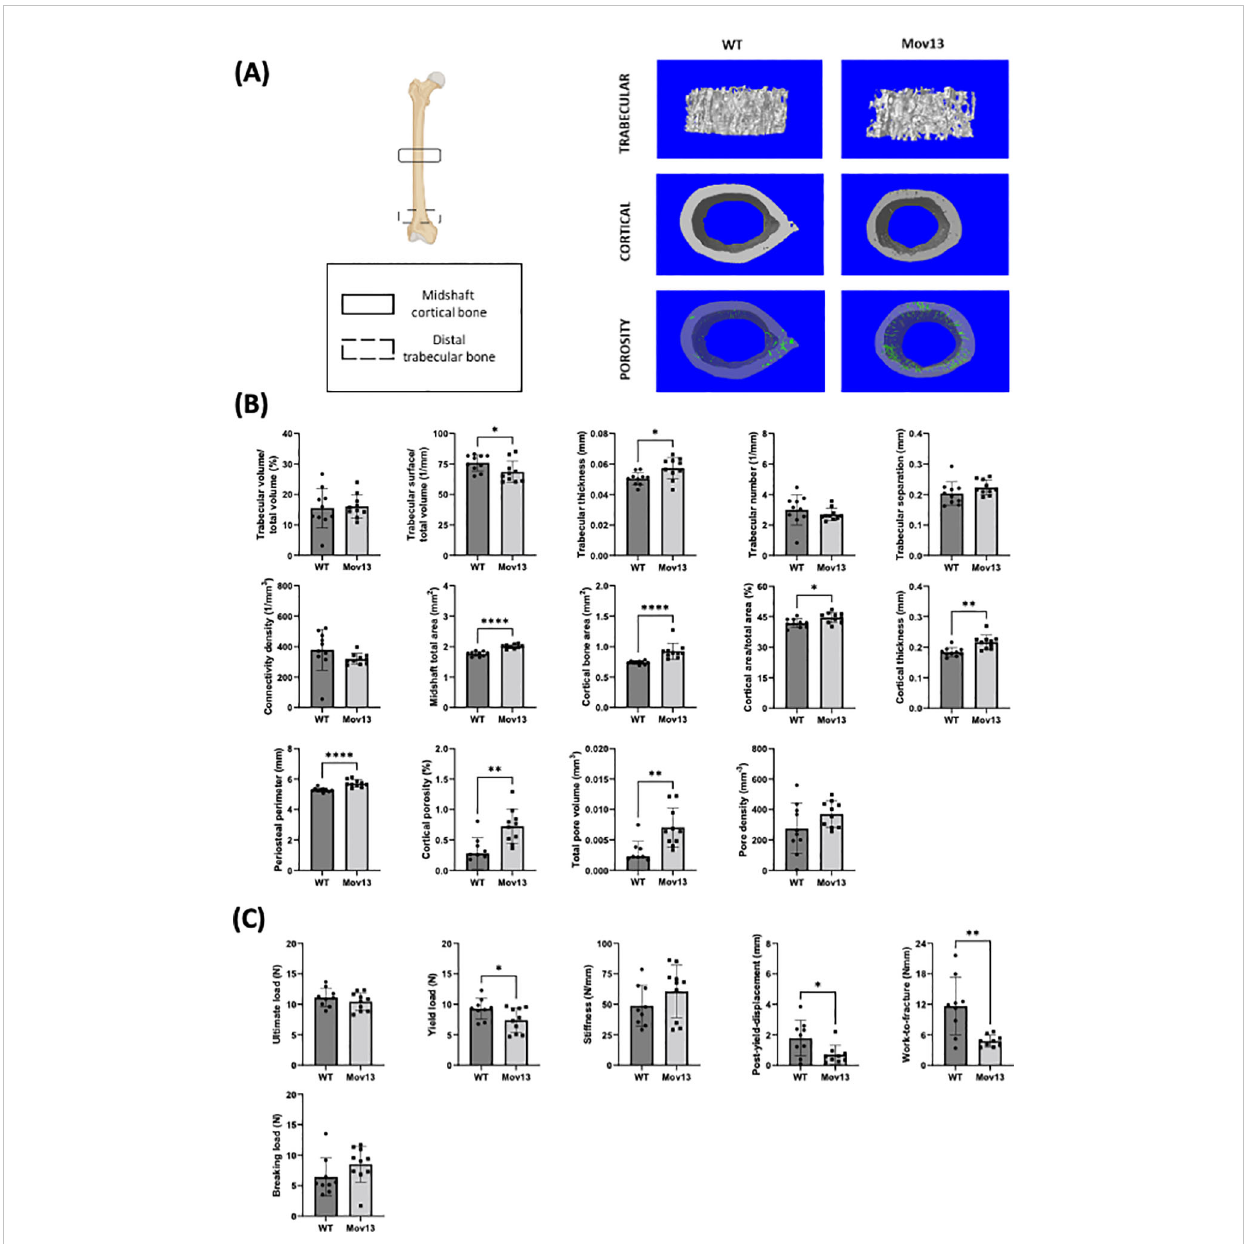
FIGURE 2 Biomechanical and structural measurements of the Mov13 mouse. (A) Schematic overview of femur showing the regions used to measure the midshaft cortical bone and distal trabecular bone and the 3D reconstructions of the microCT scans of the trabecular bone, cortical bone and cortical porosity of a wild-type and Mov13 mouse. (B) Trabecular and cortical parameters were measured from microCT scans, corrected for body weight, of Mov13 mice and wild-type littermates. Values of standard deviation (SD) are shown for each group: WT (n=10, 50%male), Mov13 (n=10, 50%male). (C) The biomechanical properties (Ultimate load, yield load, breaking load, stiffness, post-yield displacement and work-to-fracture) were measured using the load-displacement curve after 3-point bending and corrected for midshaft total area (Tt.Ar). Values of standard deviation (SD) are shown for each group: WT (n=9, 45%male), Mov13 (n=10, 50%male). Statistical signi fi cance is indicated on the graphs (P-values ≤ 0.05 (*), ≤ 0.01 (**), ≤ 0.0001 (****)). Tb.N, Ct.Ar and the breaking load were measured with a non-parametric unpaired